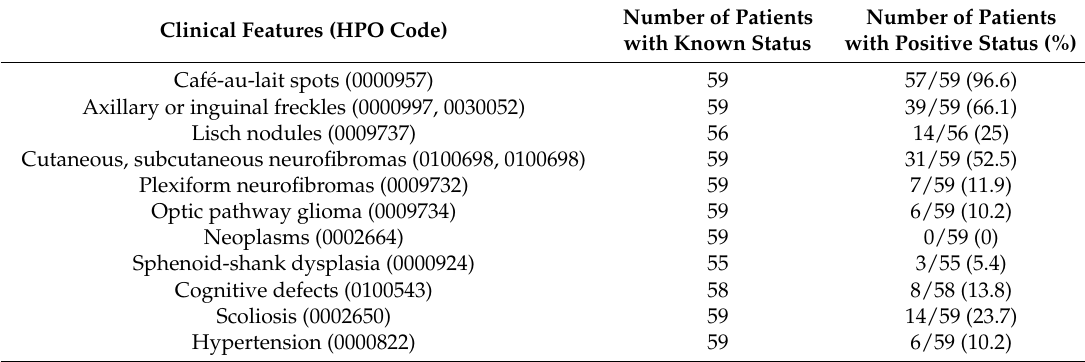
Table 3. Clinical features of patients with novel NF1